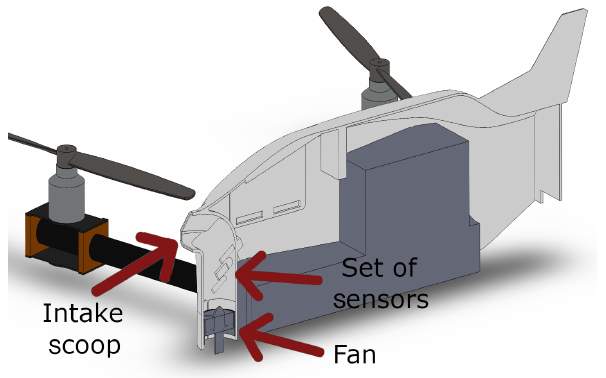
Figure 6. Longitudinal section cut view of the CopterSonde CAD model showing the different parts of the inside of the L-shaped duct. The sensors were placed as far from the intake as possible to reduce the heating produced by solar radiation. The airflow induced by the fan circulates from top to bottom at a constant